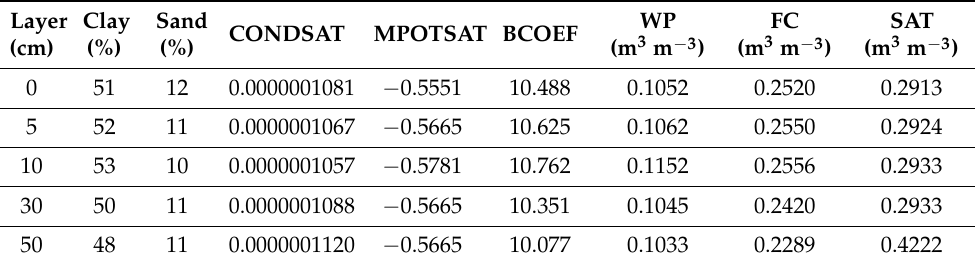
Table 3. Soil texture and soil hydraulic properties for the sap flow period.